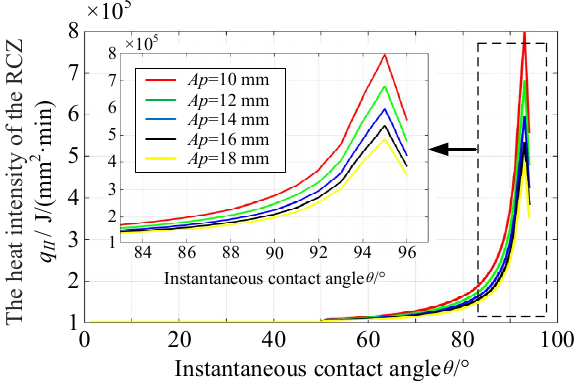
Figure 22. The heat intensity in the RCZ at di ff erent milling depths ( V = 40 m / min).